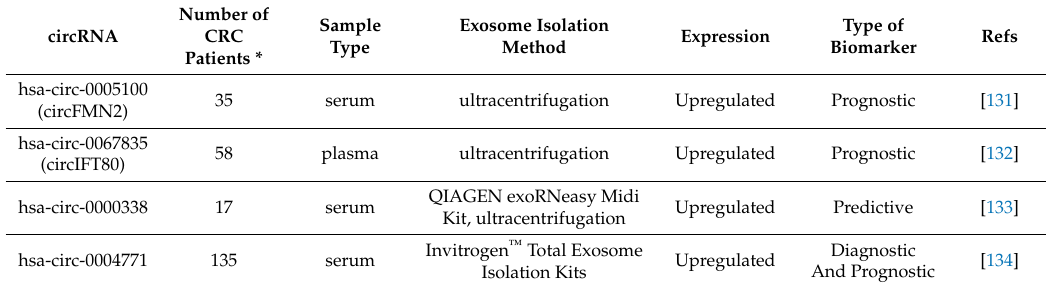
Table 3. Summary of exosomal circRNA studies in CRC